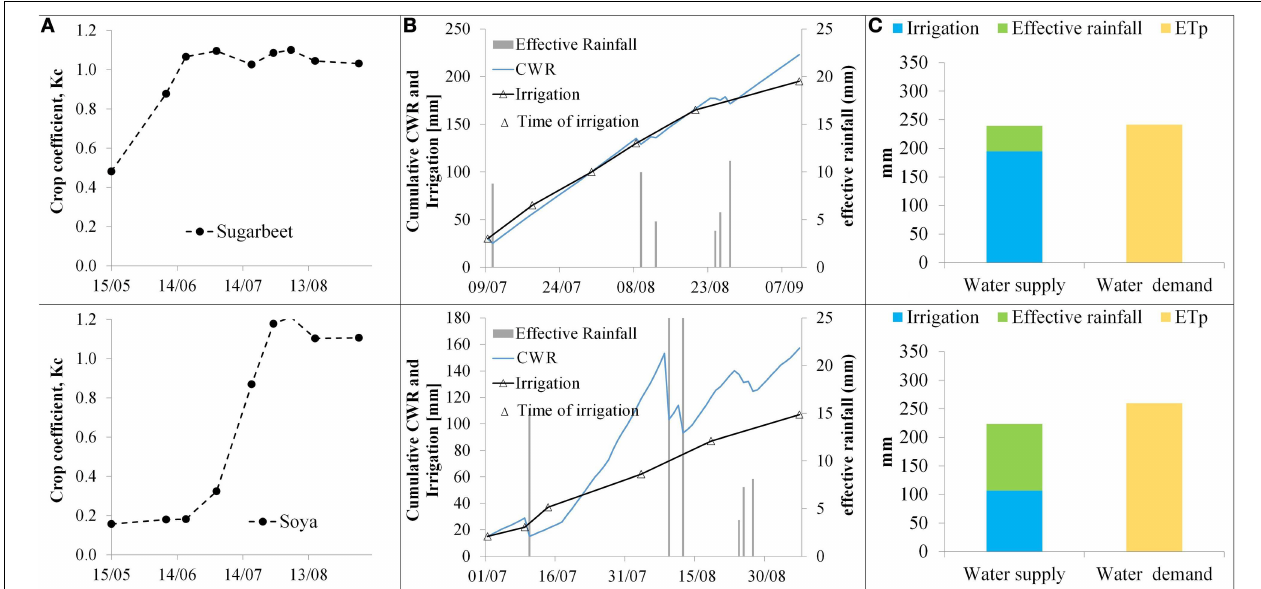
FIGURE 4 | Examples of (A) satellite-based crop coefficient, (B) Crop Water Requirements (CWR) estimated from satellite vs. supplied irrigation volumes provided by the farmers, and (C) Total water supplied (Irrigation + effective rainfall) vs. water demand (crop ET).